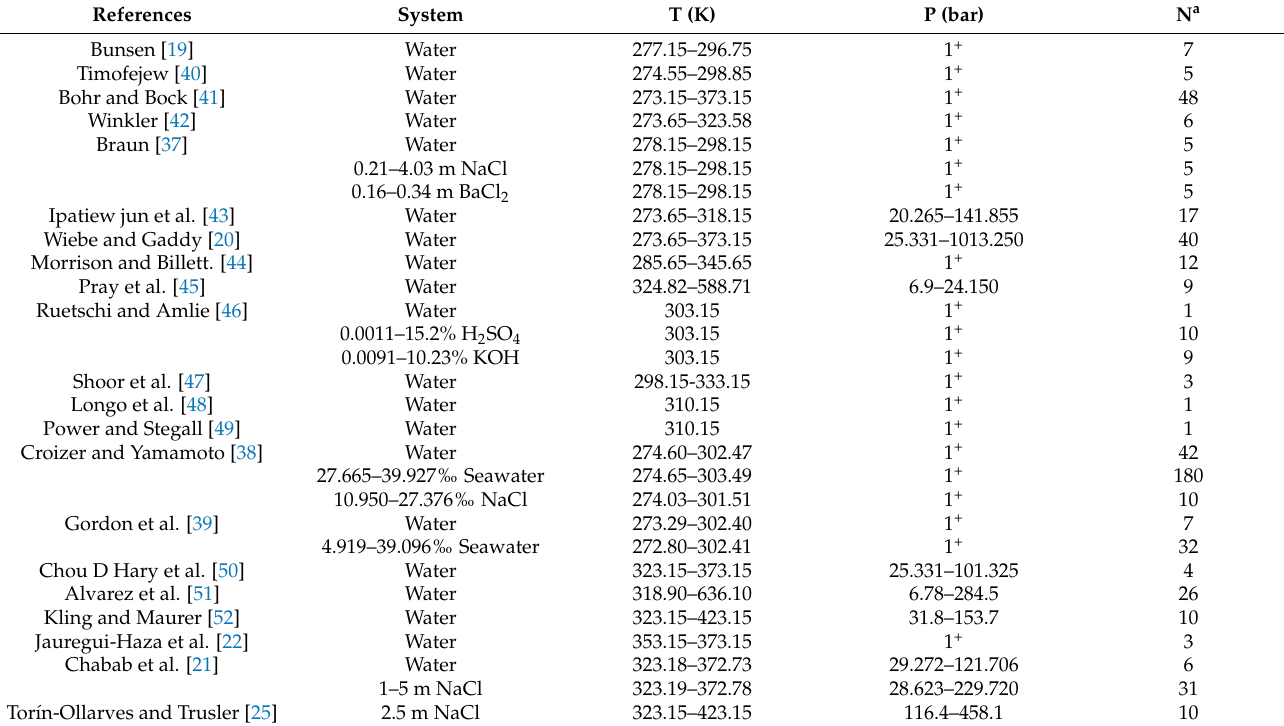
Table 2. Aqueous H 2 solubility measurements in the